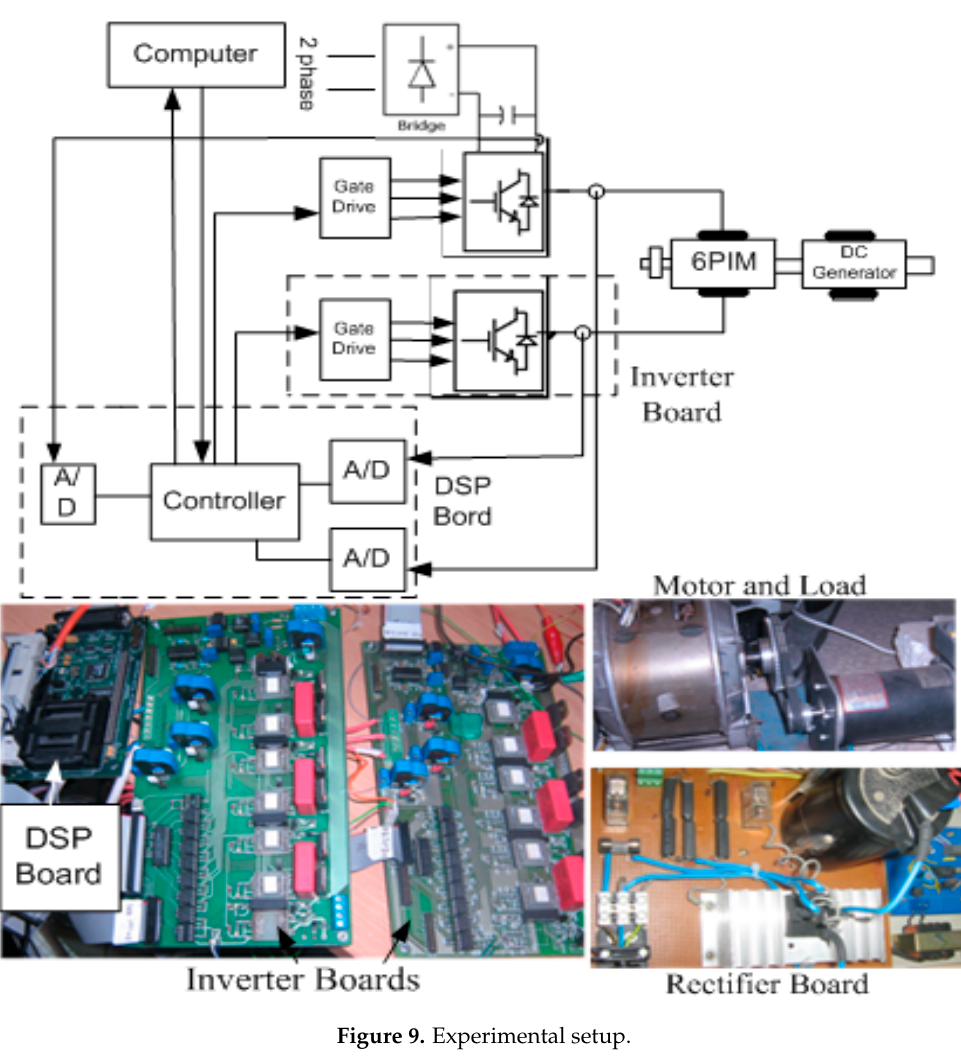
Figure 9. Experimental setup.